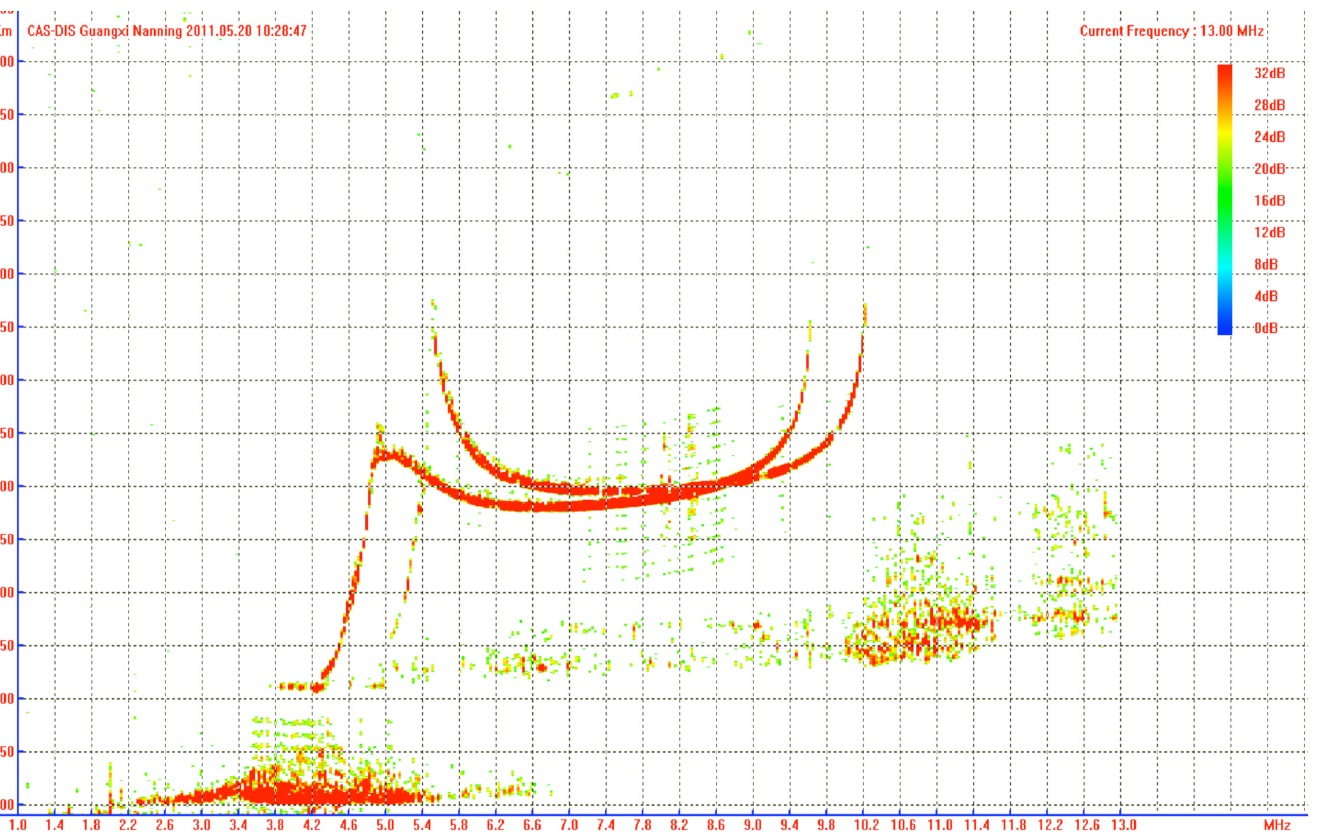
Figure 9. Test result of the CAS-DIS on May 20, 2011, for the Guangxi Nanning station (13-bit Barker